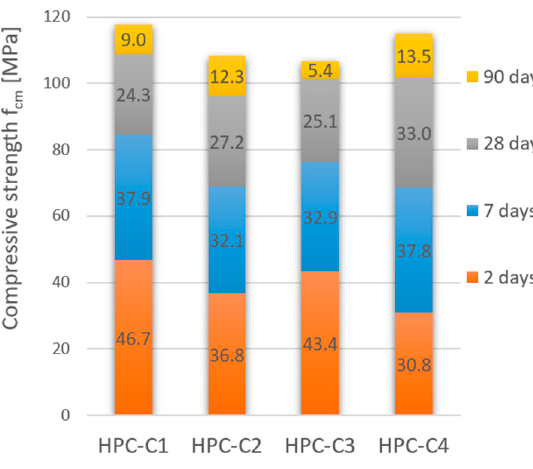
Figure 14. Compressive strength f cm —HPC concretes.